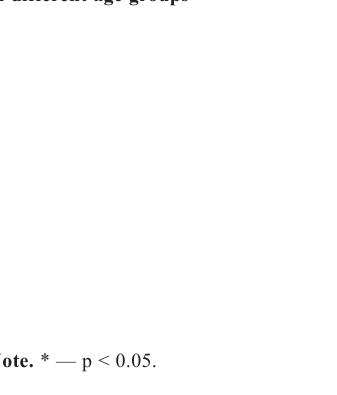
Figure 2. Mean values of thoracic kyphosis and lumbar lordosis among girls and boys of different age groups